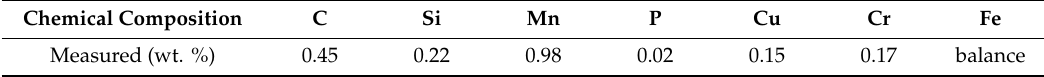
Table 1. Chemical composition of C45 steel used as substrate. Chemical